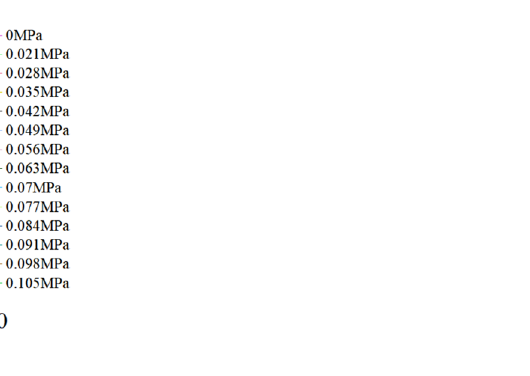
Figure 10. Displacement nephogram of all measuring points on roadway roof surface.